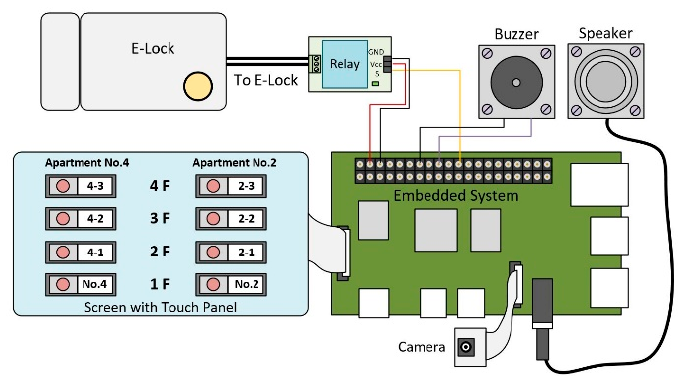
Figure 3. Hardware architecture of smart intercom system.